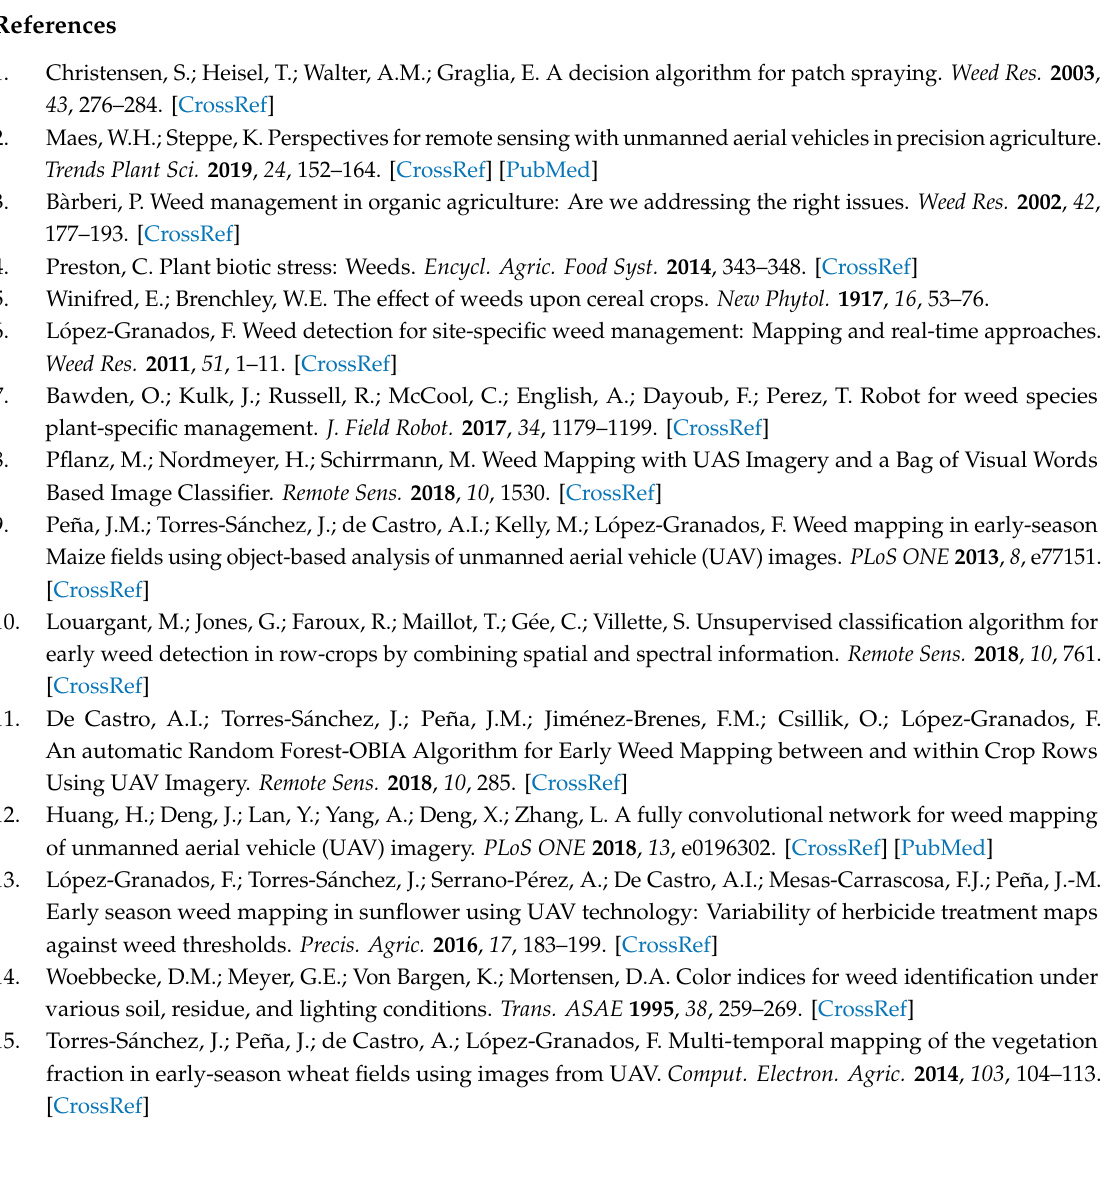
Figure A1. WP value distribution ( left ) and corresponding box-plot ( right